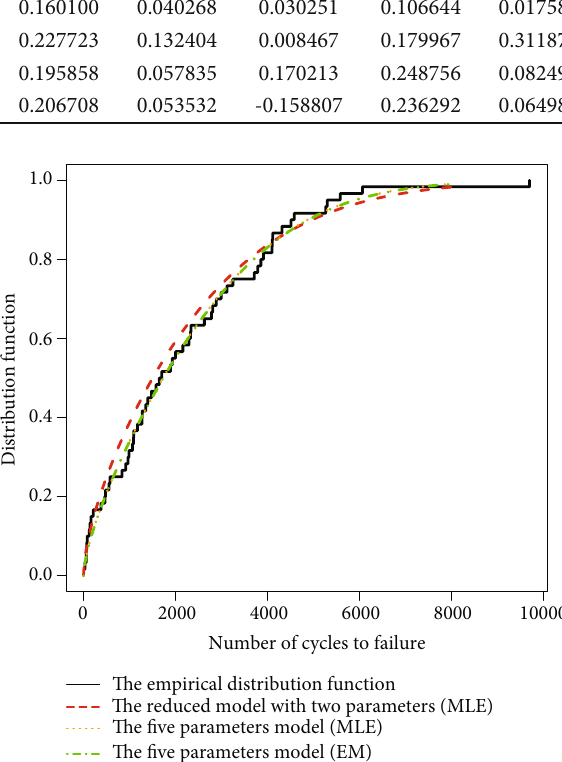
Figure 2: The empirical CDF and some fi tted models to data set